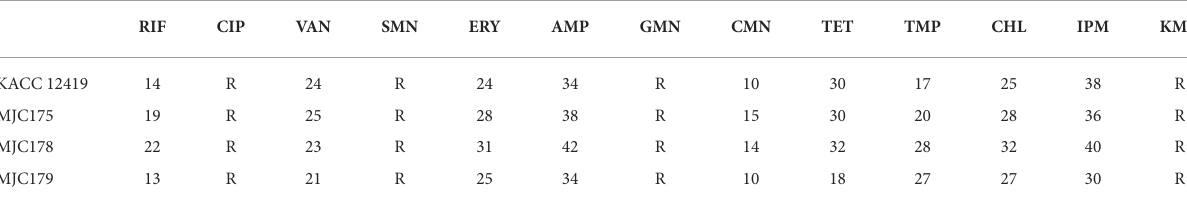
Diameter (mm) of inhibition